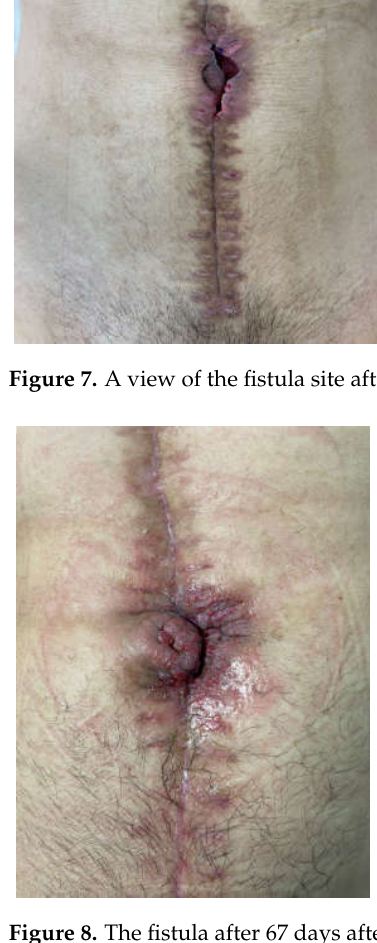
Figure 8. The fistula after 67 days after removal of the colostomy bag